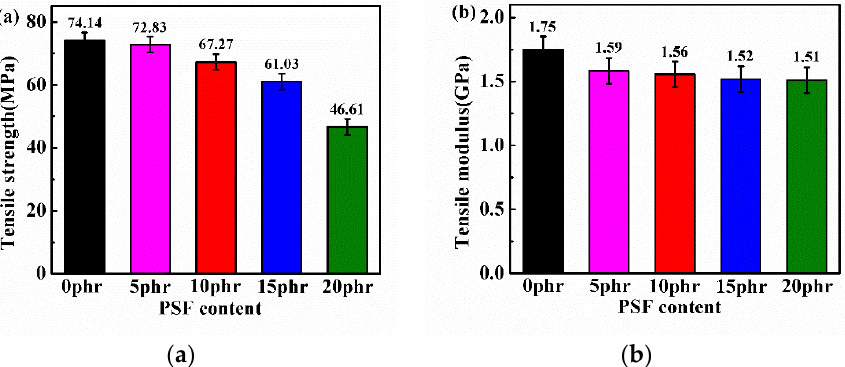
Figure 6. The tensile strength ( a ) and Tensile modulus ( b ) of cured PSF/epoxy blends.